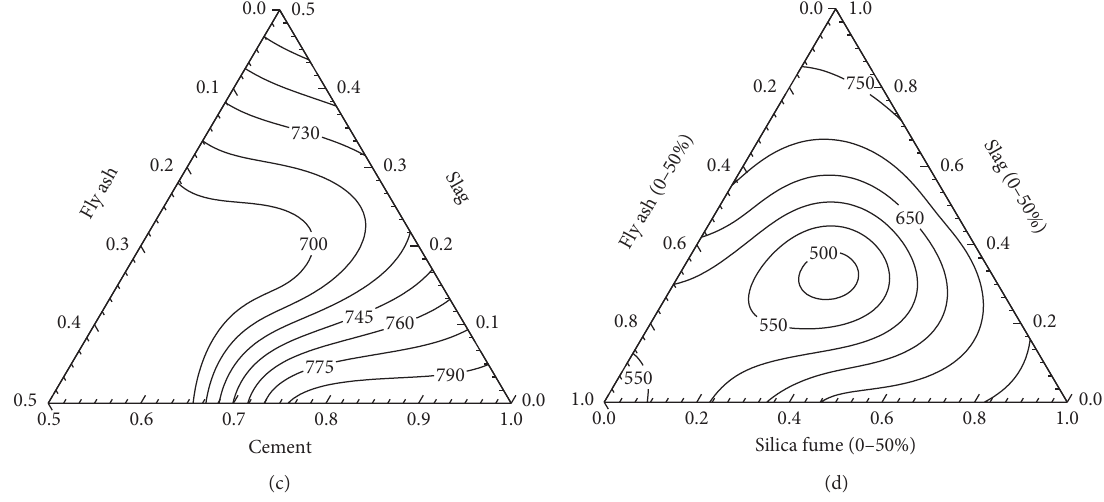
Figure 9: Dry shrinkage of UHPC (28 d) with cementitious system of cement-silica fume-slag-fly ash